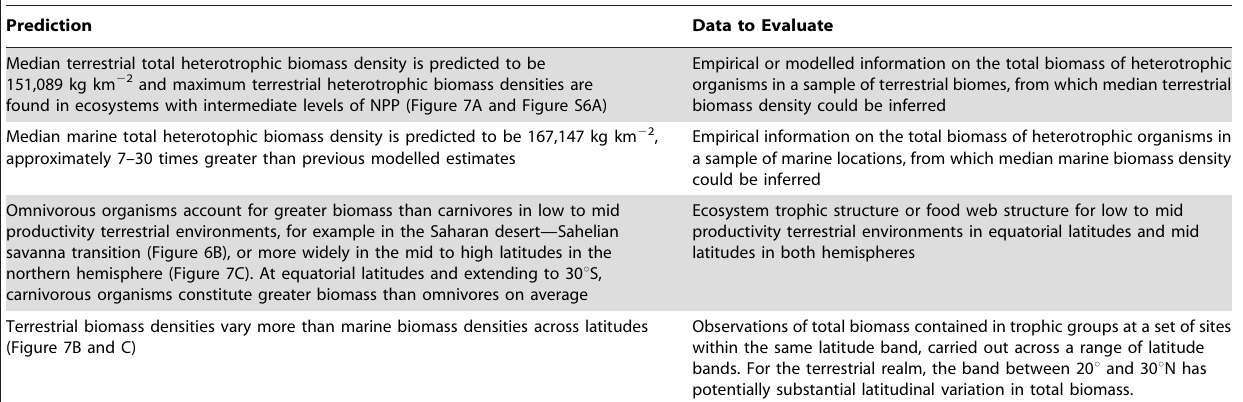
Table 8. Novel predictions and datasets needed to evaluate them.